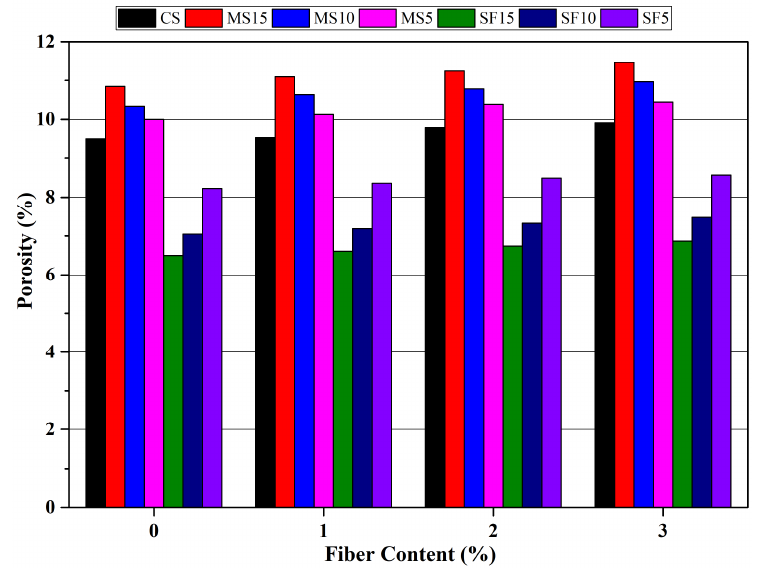
Figure 7. Apparent porosity values of the mortar samples